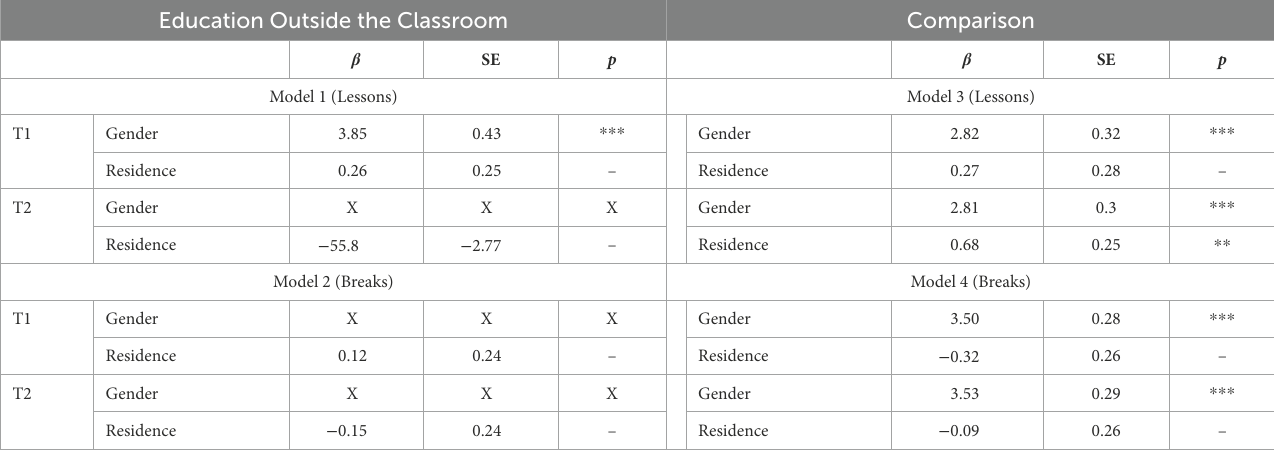
TABLE 5 Results of testing for homophily effects. Education Outside the